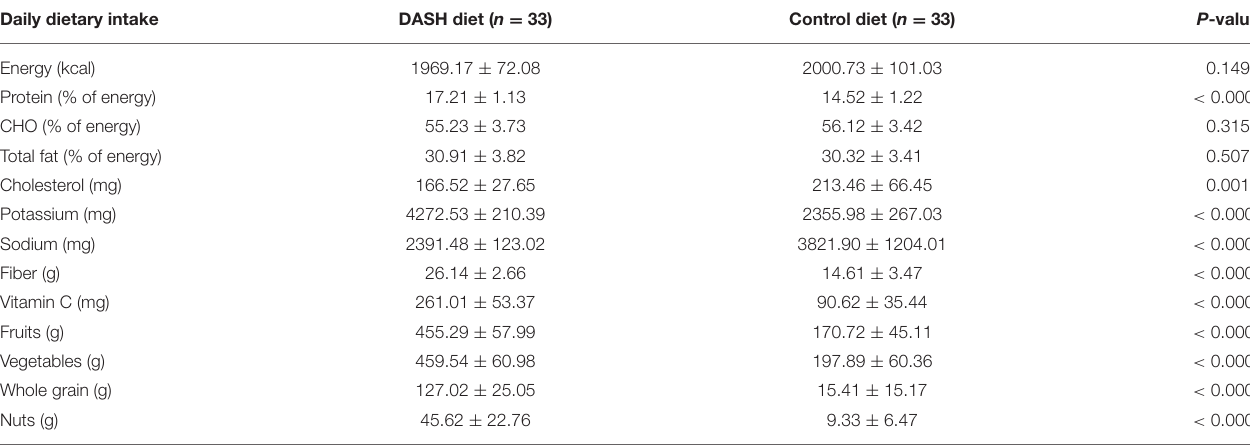
TABLE 3 | Dietary intakes of participants (patients with type 2 diabetes) during 3-month intervention period. Daily dietary intake DASH diet ( n =